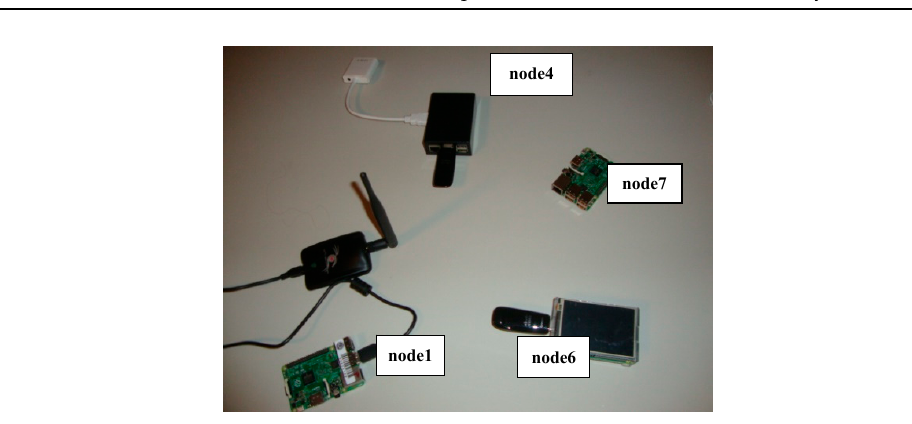
Table 5. Configuration for the 4 RPi based PWMNS.